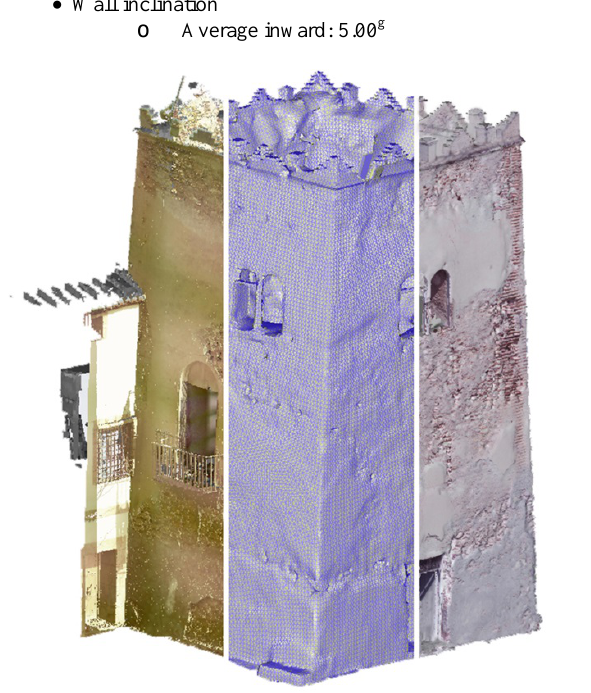
Figure 7. Point cloud, triangle mesh and textured of the model of the Negro Tower, processed with 3D Reshaper.